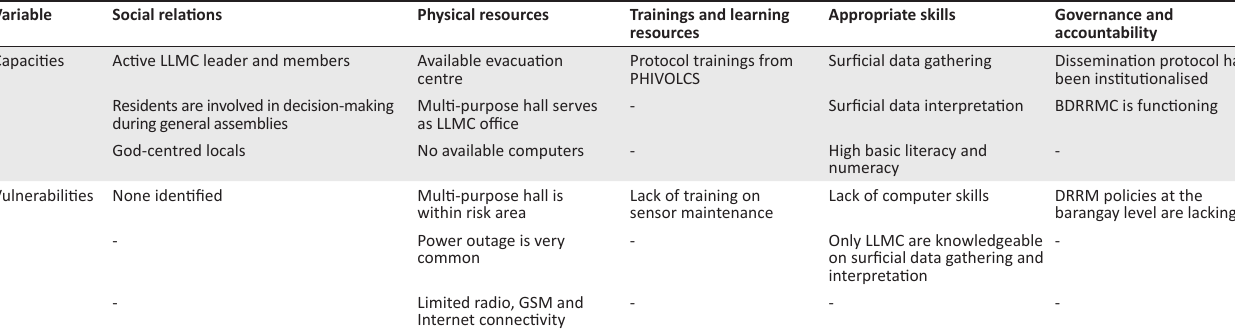
TABLE 6: Categorised capacities and vulnerabilities of site D2. Variable